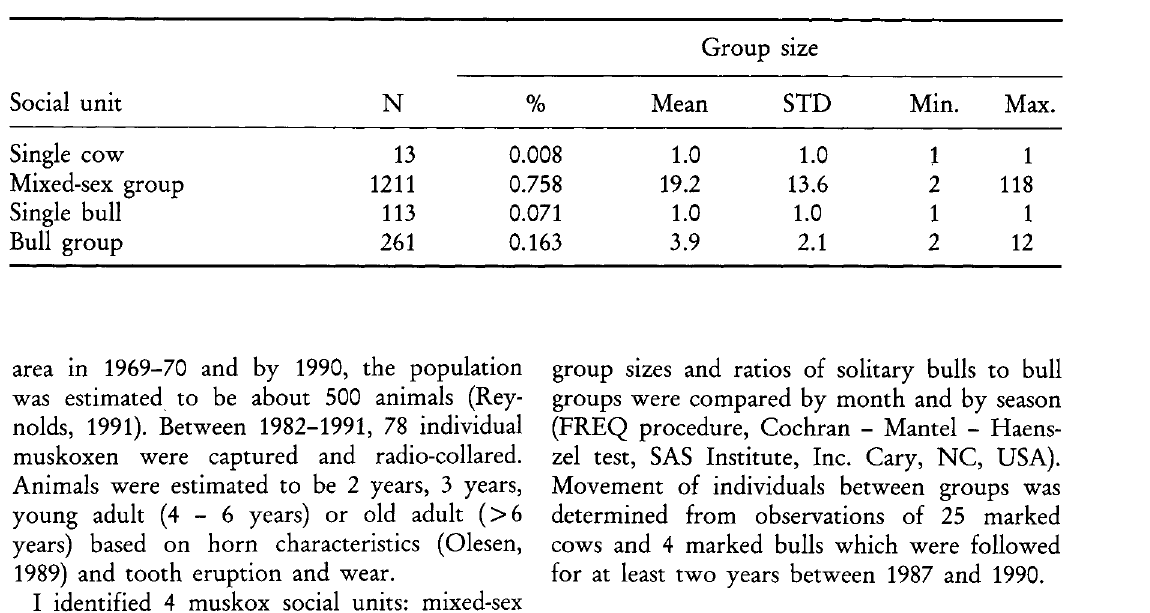
Table 1. Characteristics of muskox social units in northeastern Alaska, 1982-1991.